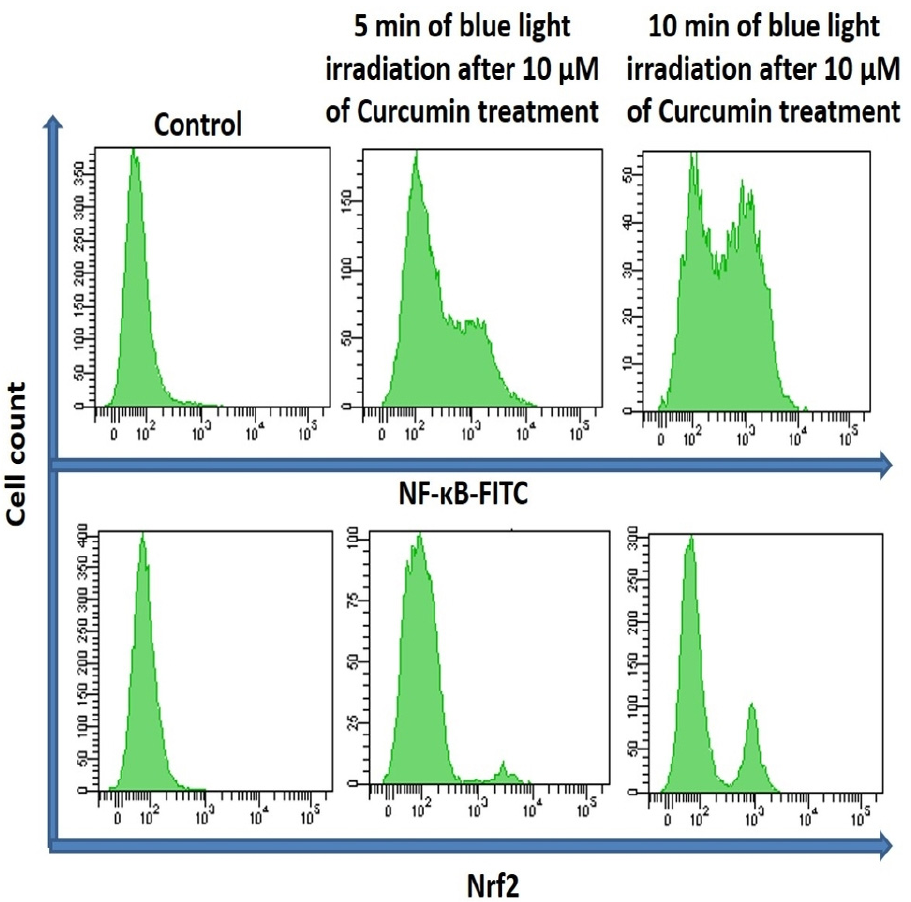
Figure 7. Measurement of NF- κ B and Nrf2 in the presence and absence of blue light (with and without Curcumin).